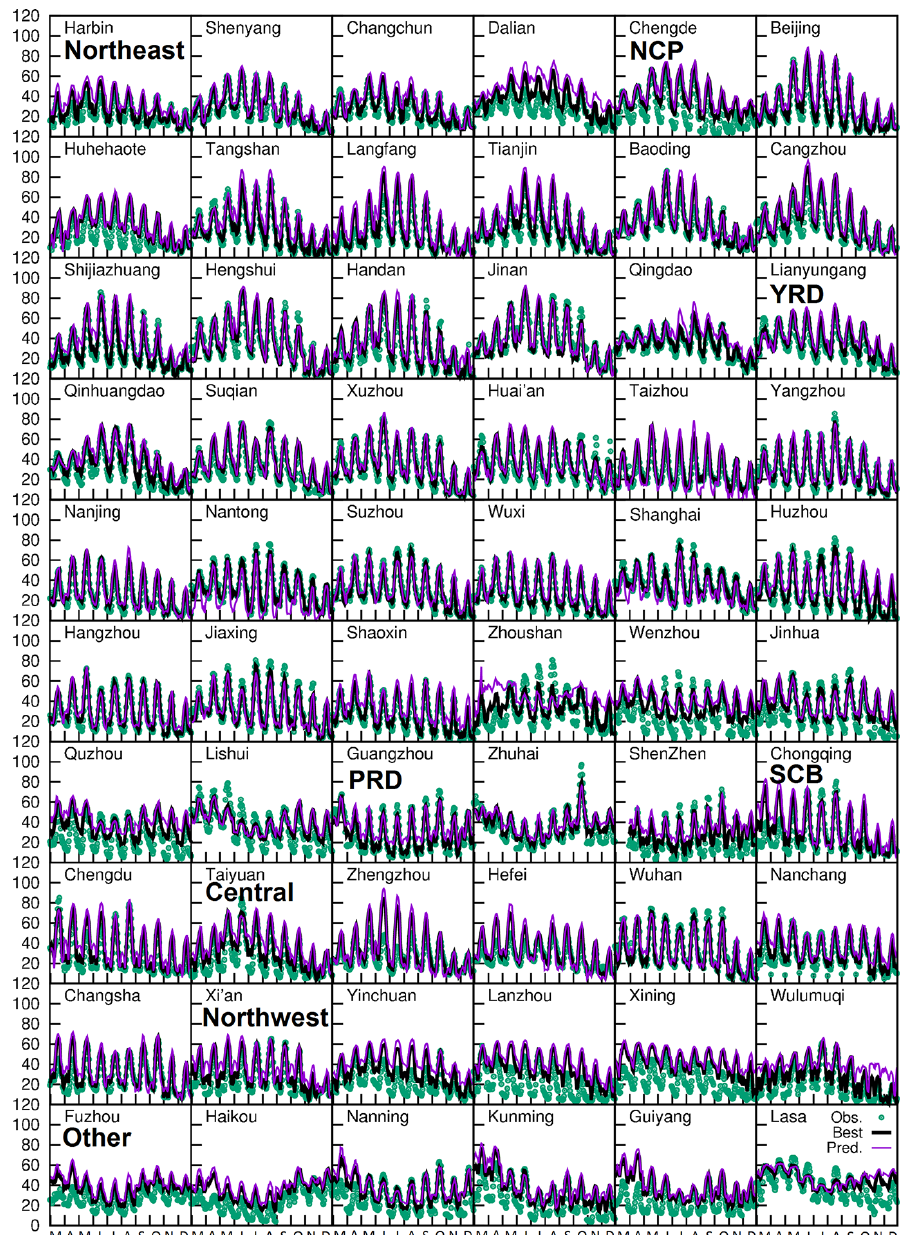
Figure 2. Comparison of monthly averaged diurnal variations of O 3 concentrations from March to December 2013. Pred. are the values predicted at the grid cell each city center located while Best are the values predicted closest to the observations within 3 × 3 grid cell regions that surround the observation. Units are